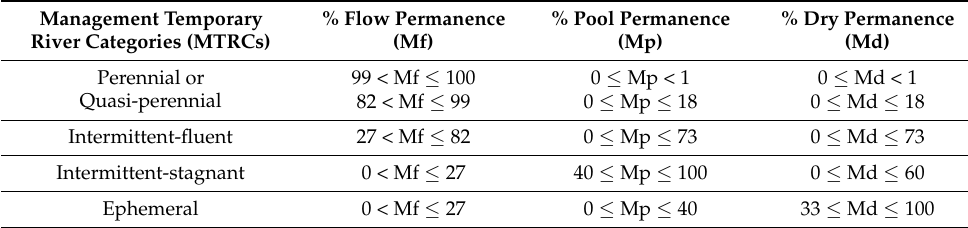
Table 3. Criteria to set the four “management temporary river categories” (MTRCs): perennial or quasi-perennial, intermittent-fluent, intermittent-stagnant, and ephemeral, proposed in the Mediter- ranean Spanish basins [54] according to the three main axis (aquatic phases): flow permanence (Mf), disconnected pools permanence (Mp), and dry river permanence (Md) provided by TREHS software. Management Temporary % Flow Permanence % Pool Permanence % Dry Permanence River Categories (MTRCs) (Mf) (Mp) (Md) Perennial or